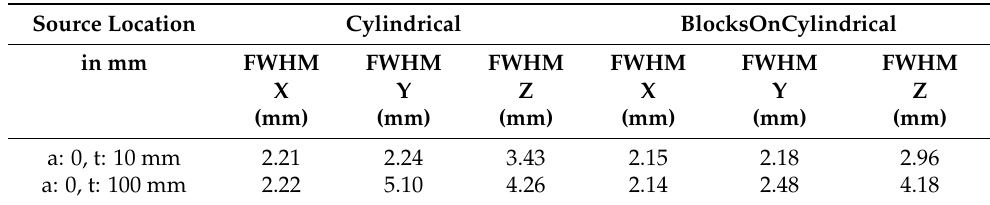
Table 1. FWHM of two simulated point sources; “a”, “t” stands for axial and transaxial; X, Y, and Z follows the LPS coordinate where: X is from right to left, Y is anterior toward posterior, and Z is from inferior to superior.